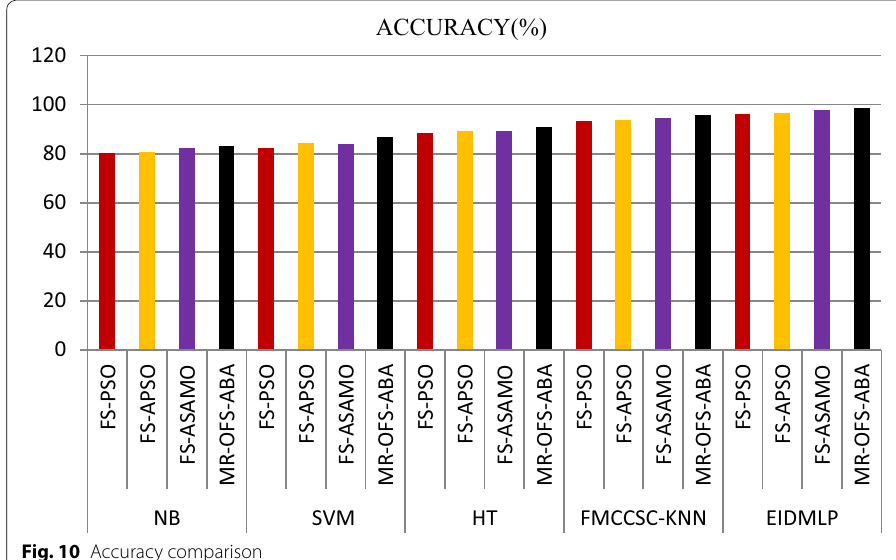
Fig. 10 Accuracy comparison